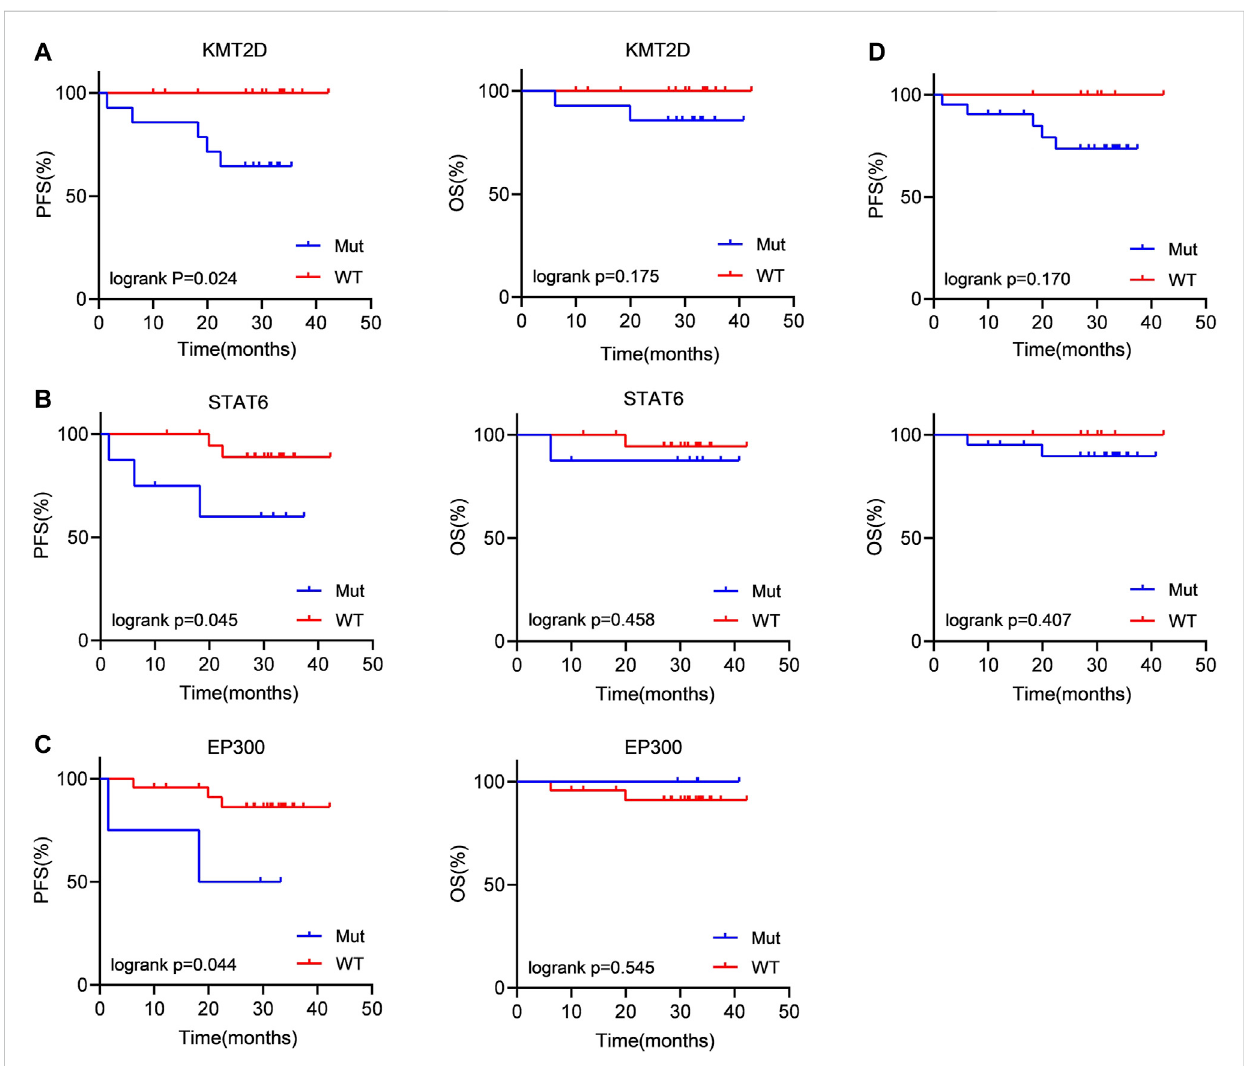
FIGURE 3 PatientscarryingKMT2D,EP300andSTAT6mutationstendedtohaveapoorprognosis (A – C) Kaplan ‒ MeiercurveswereappliedtocomparetheOS and PFS between patients carrying KMT2D, EP300 and STAT6 mutations and those without KMT2D, EP300 and STAT6 mutations. (D) Kaplan ‒ Meier curves were applied to compare the OS and PFS between patients with ctDNA mutation and without ctDNA